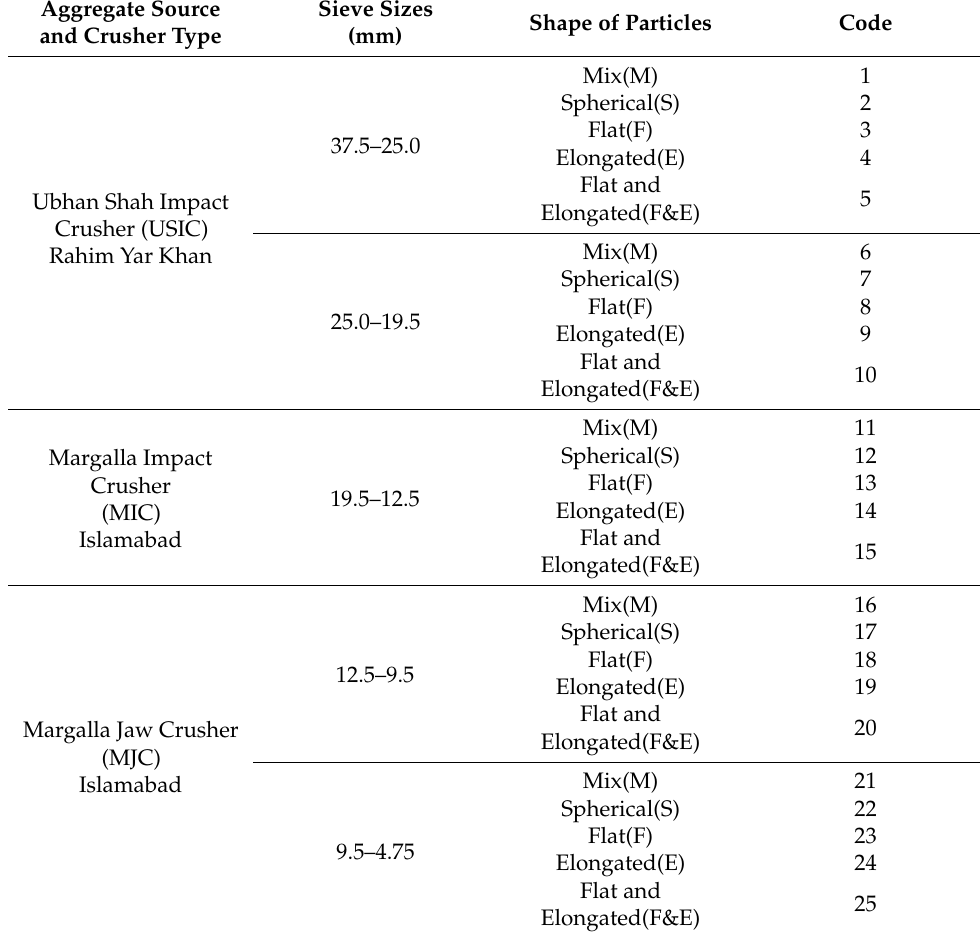
Table 4. Designation codes of aggregate fractions in MIC, MJC and USIC.